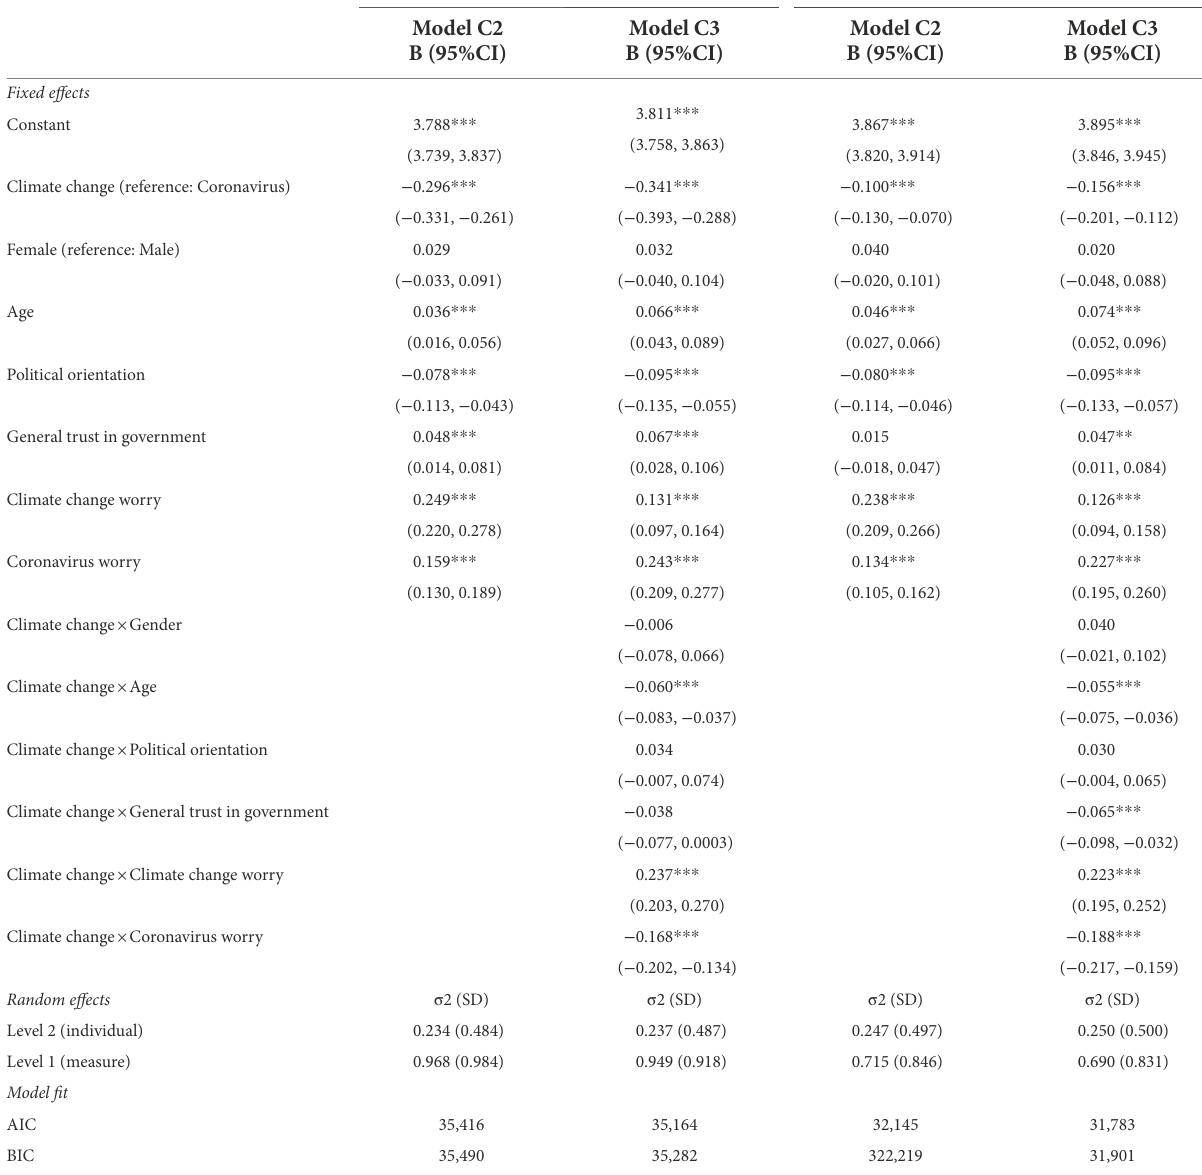
TABLE 5 Support for policies targeting individuals and businesses (Models C2 and